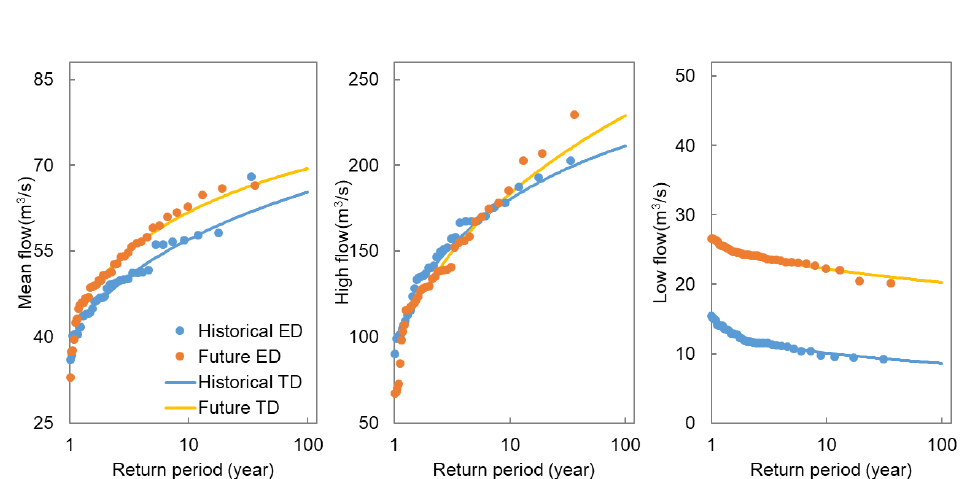
Figure 12. The estimated return levels of annual mean flows, high flows, and low flows.